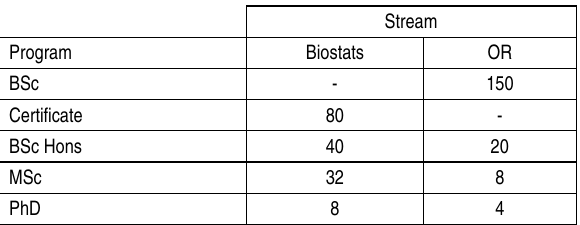
Table 3. Envisaged annual numbers of students